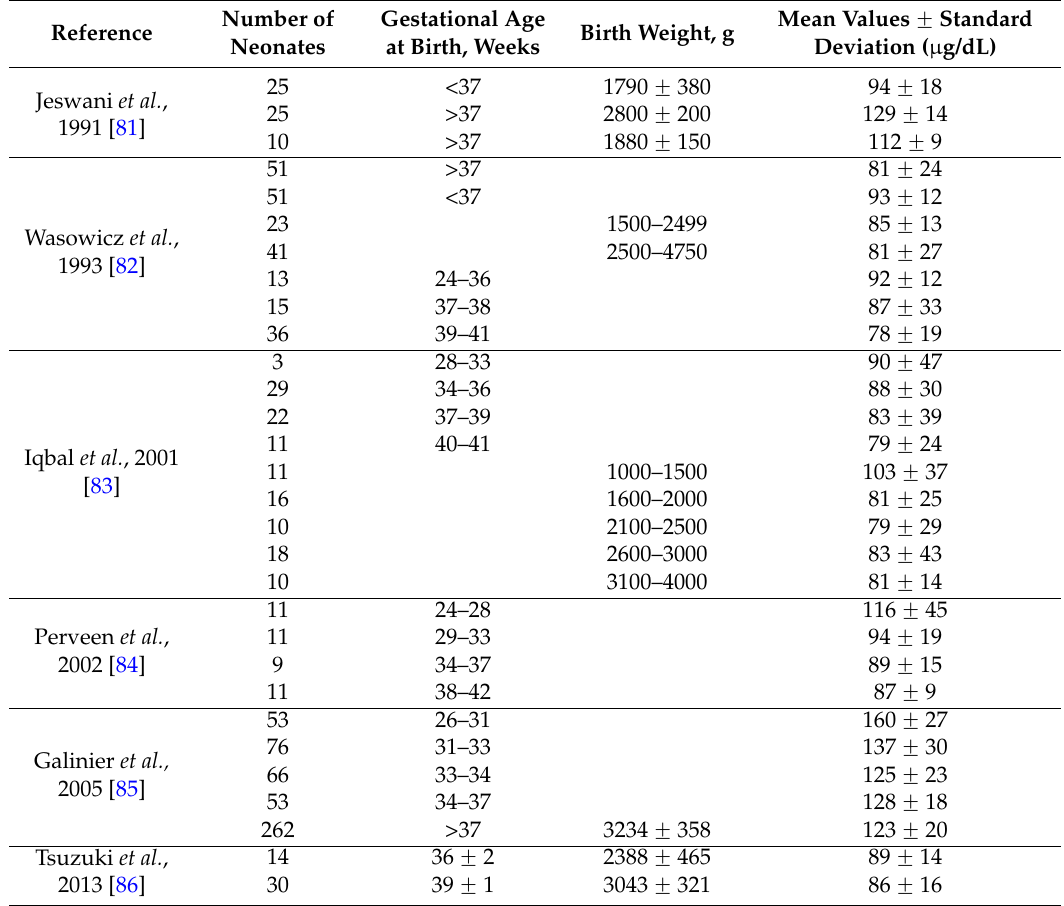
Table 6. Zinc levels in neonatal cord blood at birth by gestational age and birth